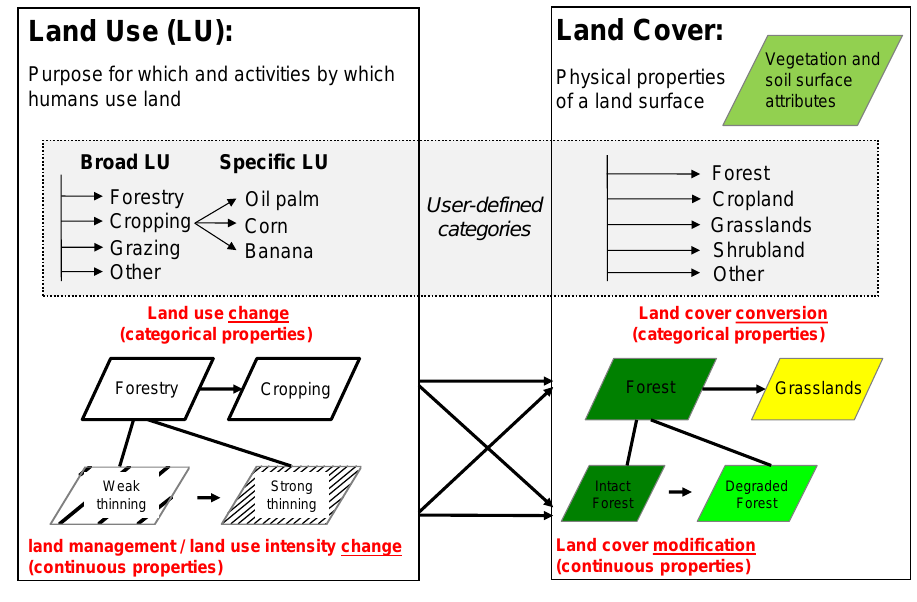
Figure 1. Conceptual sketch and examples of the relations between land use and land cover conversions and